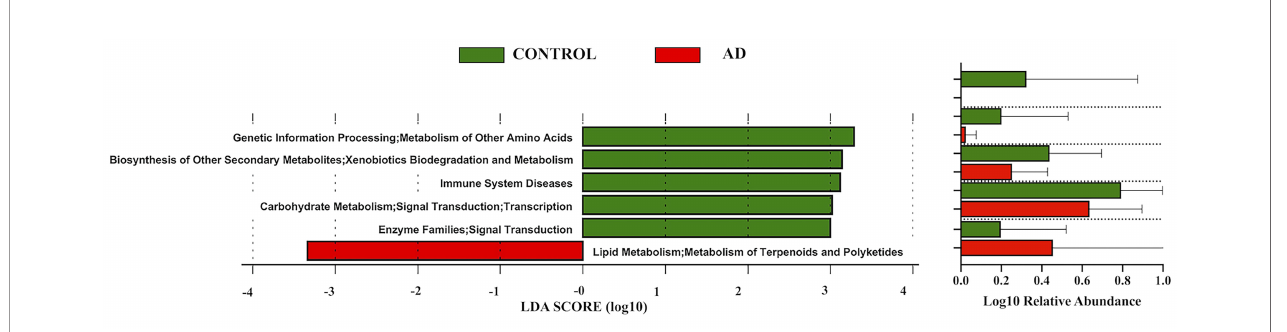
TABLE 2 | The comparative results of urinary organic acids between children with atopic dermatitis and without (controls). Items Controls Adipic acid